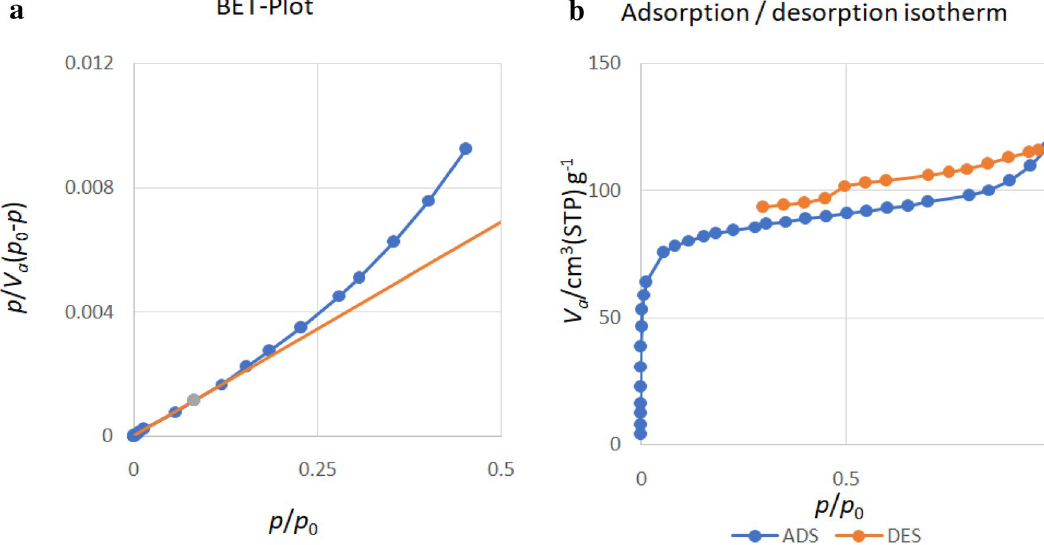
Figure 6. ( a ) The magnetic nanobiocomposite adsorption/desorption cure, ( b ) the magnetic nanobiocomposite BET curve.